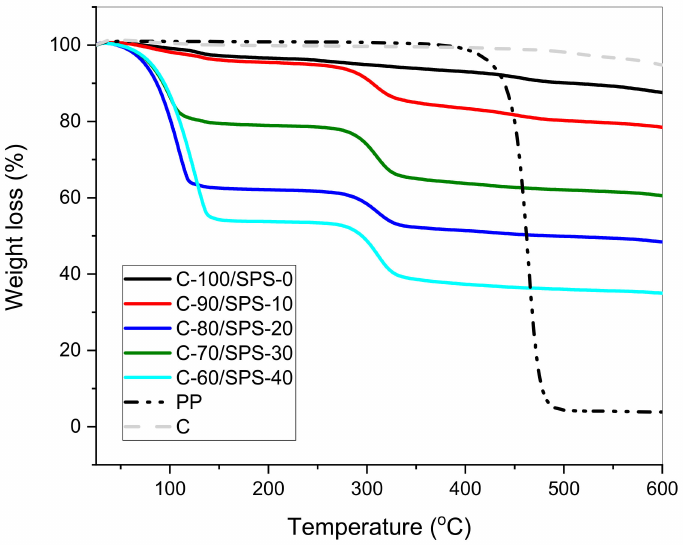
Figure 8. TGA curves for the raw PP, yielded char, and char briquettes within the temperature range of 25–600 ◦ C.